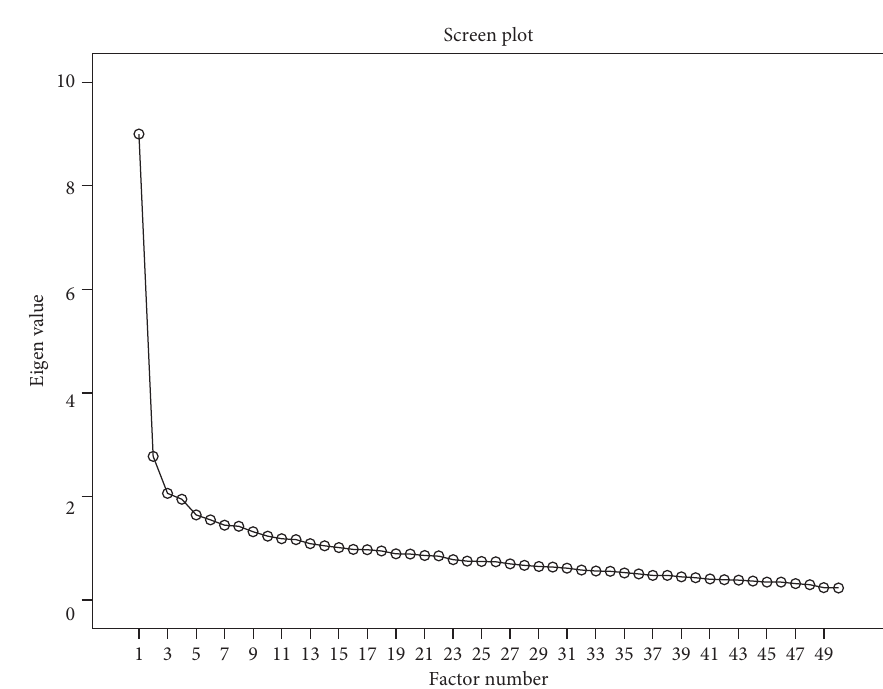
Figure 1: Descriptive analysis and identification of factors based on Driving Behavior Questionnaire